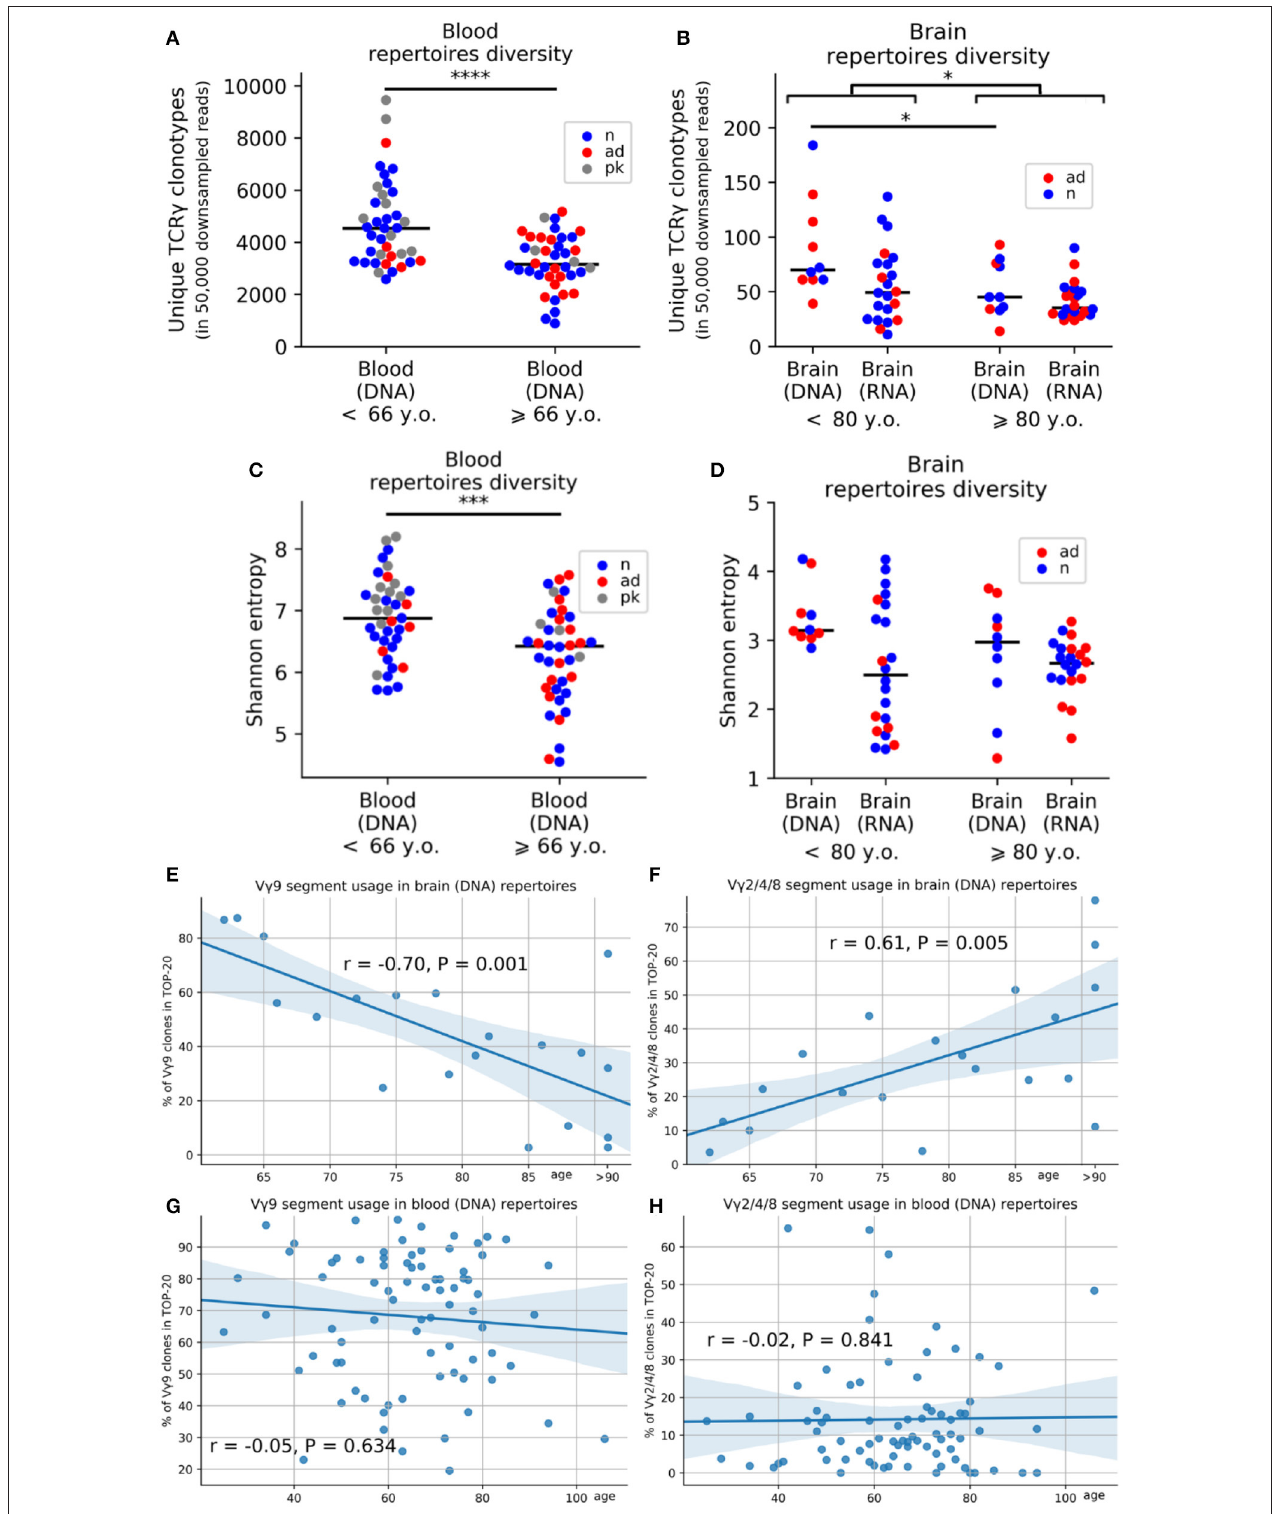
FIGURE 2 | Age-related changes in the composition of the TRG repertoire in the blood and brain. Average numbers of unique clones after downsampling the data to 50,000 reads (A,B) . Changes in Shannon entropy with age in the peripheral blood (C) and brain (D) (red, AD samples; blue, control samples; gray, patients with Parkinson’s disease). Regression analysis of V-segment frequencies in the top 20 clones for the TRGV9 segment (E) and TRGV2/4/8 segments (F) in the cerebral cortex and peripheral blood (G,H) . * P < 0.05, *** = < 0.001 and **** P < 0.0001.